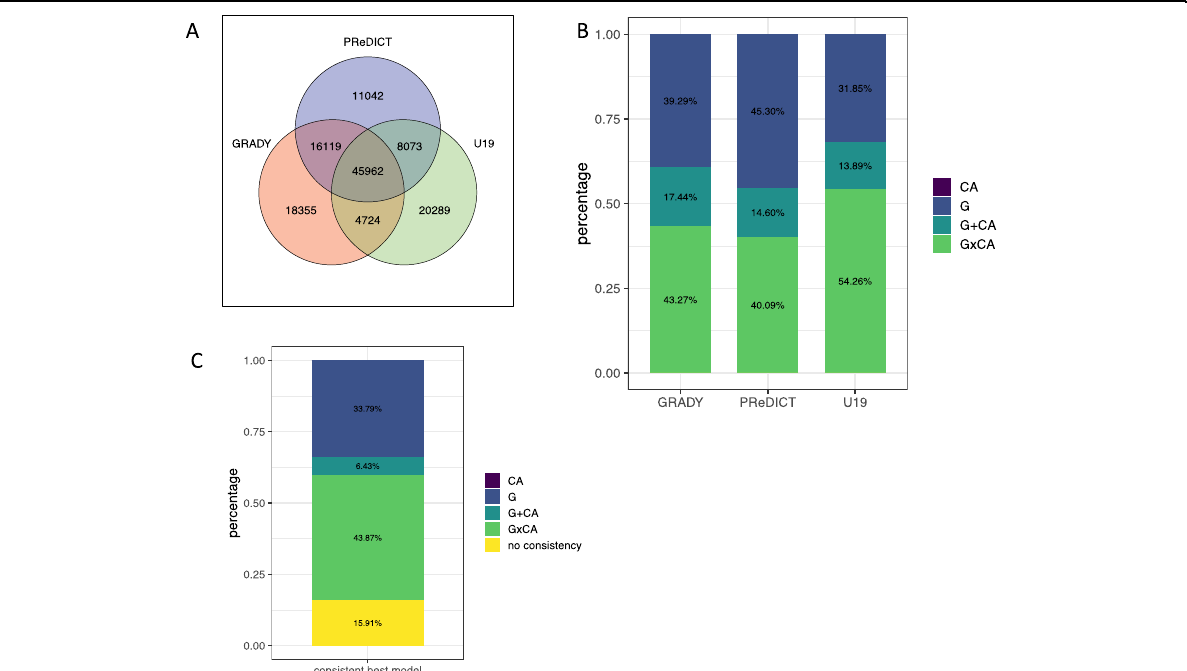
Fig. 1 Overlapping VMPs between GRADY, PReDICT, and U19. Venn diagram of overlapping VMPs for GRADY, PReDICT, and U19 at a MAD score threshold at the 80th percentile ( a ). Distribution of the best models explaining variation in DNAm across the three adult cohorts. Percentage of overlapping VMPs ( n = 45,962) best explained by G, CA, G + CA, or G × CA in each cohort using the highest adjusted R 2 ( b ). Consistent best models across three adult cohorts. Percentage of overlapping VMPs ( n = 45,962) best explained by the same model type (G, CA, G + CA, or G × CA) in at least two cohorts ( c